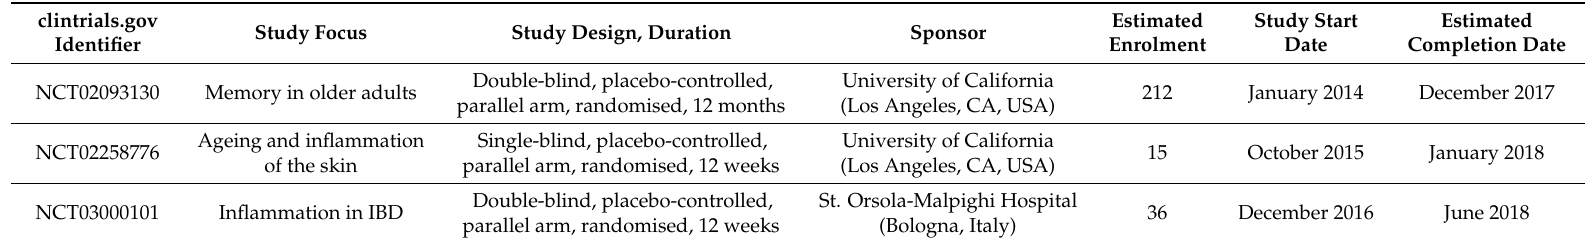
Table 3. Ongoing clinical trials on pomegranate juice